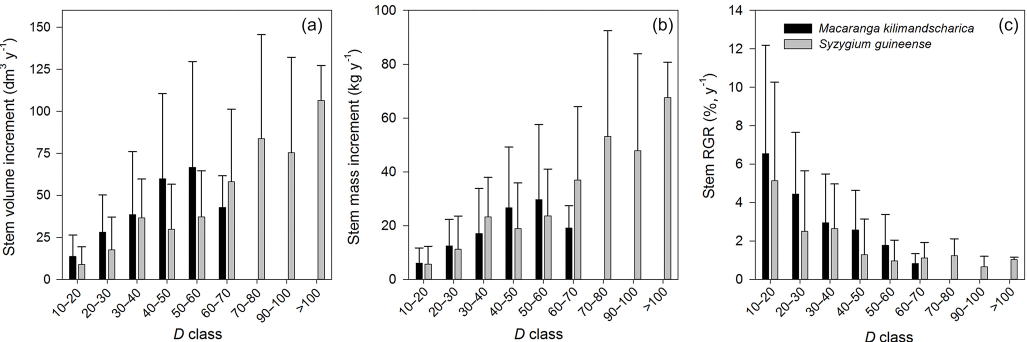
Figure 4. Annual stem volume increment (a) , mass increment (b) and relative growth rate (c) for M. kilimandscharica ( n = 112) and S. guineense ( n = 119) distributed over all available D classes and all plots. Stem production estimates are based on nine consecutive recordings over 3 years of D with fixed dendrometer bands. The volume increment, mass increment and relative growth rate (RGR) of stems averaged over the six lowest D classes (10 to 70cm) were 53% ( P = 0 . 012), 6% ( P = 0 . 62) and 35% ( P = 0 . 027) larger for M. kilimandscharica compared to S. guineense . Mean weighted values based on D classes were used in the